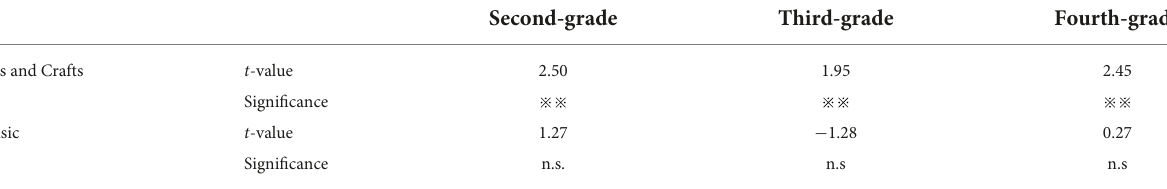
TABLE 5 Differences in performance in arts and crafts and music, and changes in the significant difference in records for the repeated side jump by grade level.